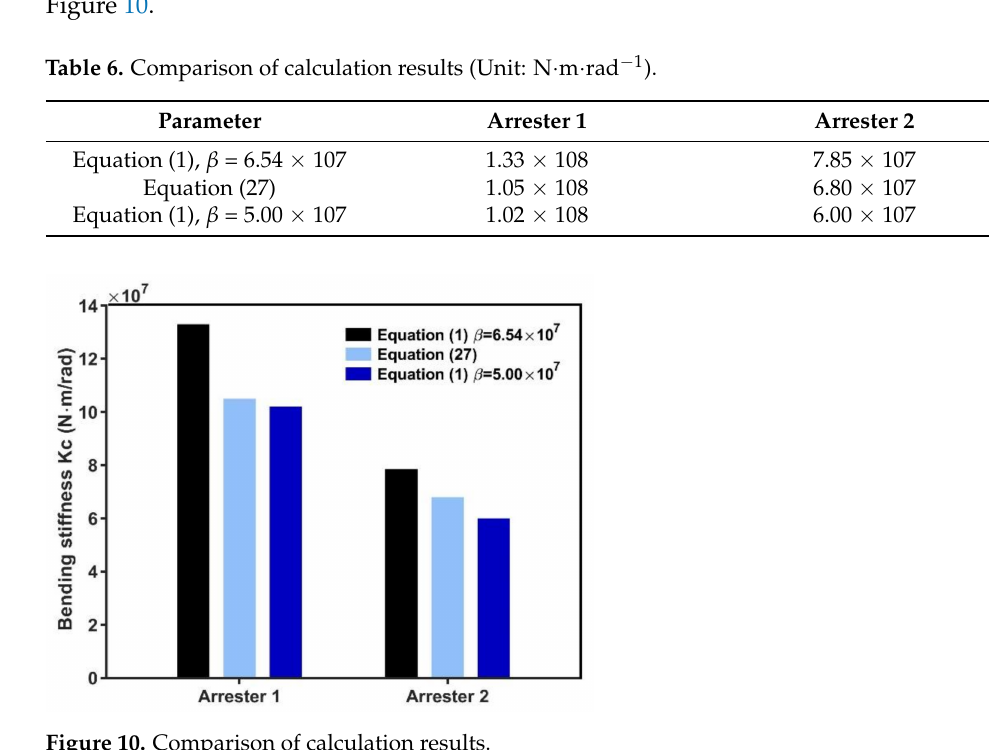
Figure 10. Comparison of calculation